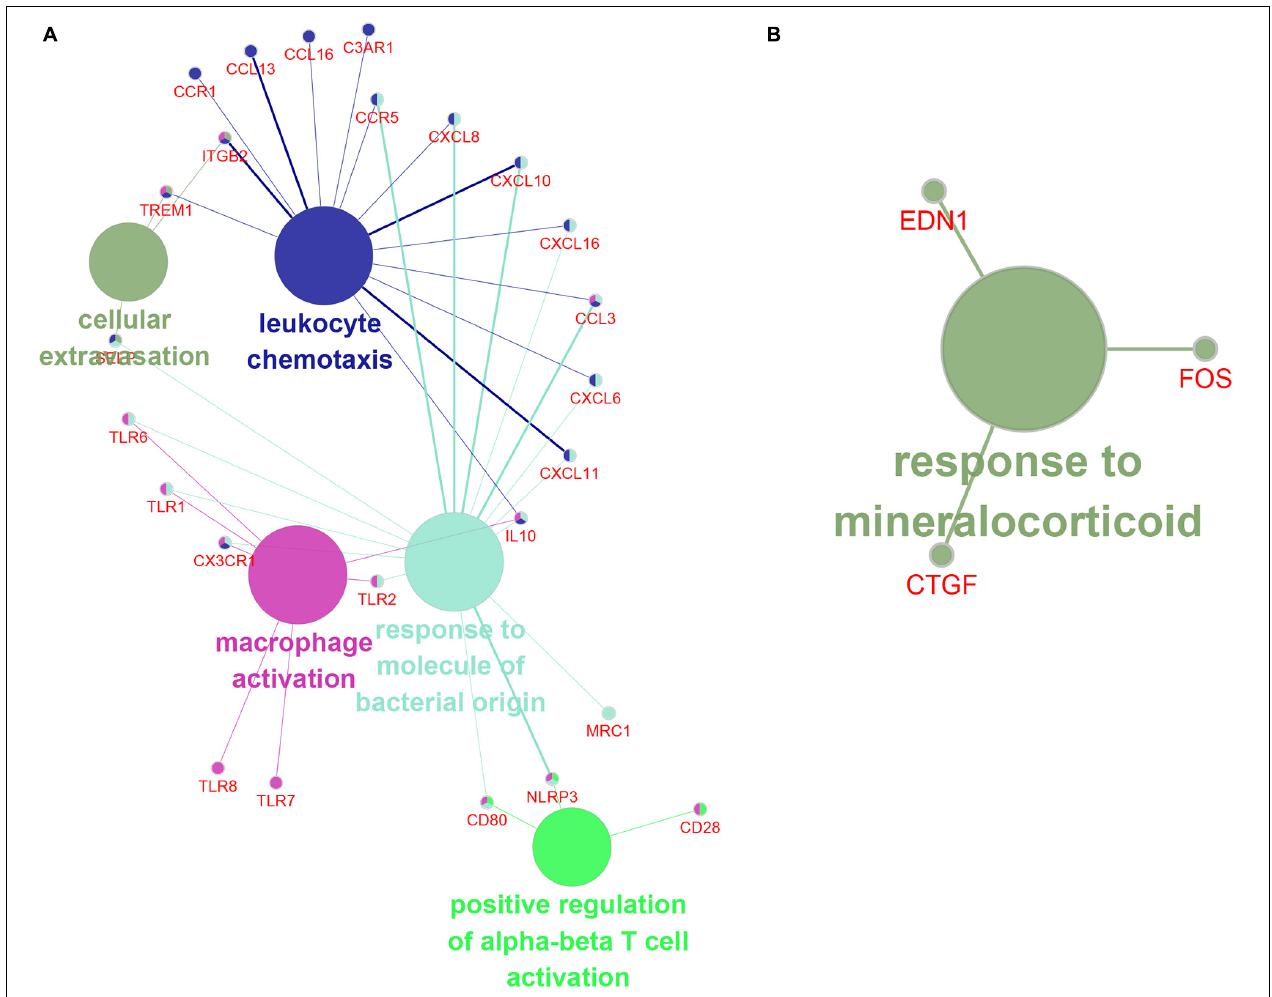
FIGURE 8 | The function prediction of hub gene and lncRNA of turquoise module. (A,B) The function prediction of Hub mRNAs (A) and lncRNAs (B) of turquoise